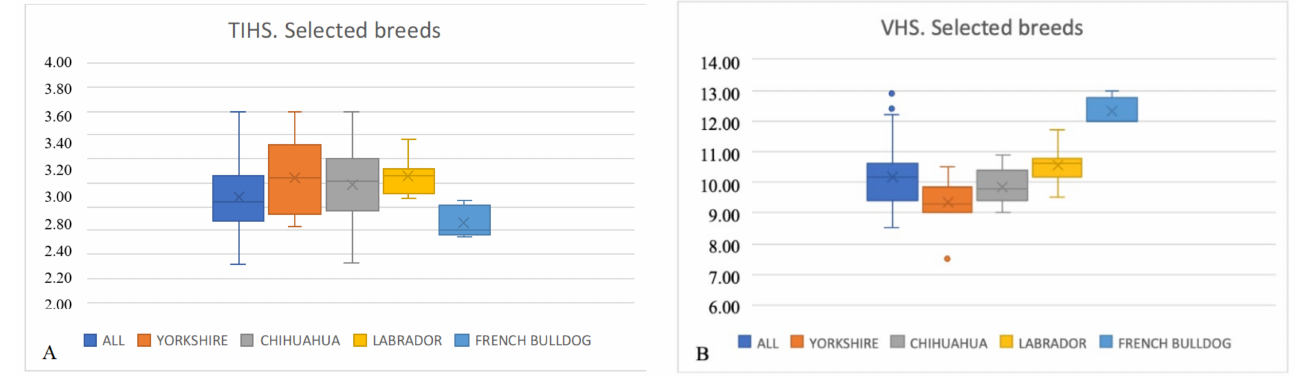
Figure 3. Box plots illustrating TIHS ( A ) and VHS ( B ) for the general population and four most represented dog breeds. Dots represent